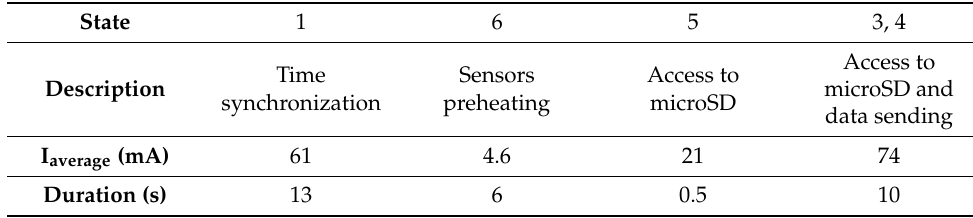
Figure 8. Node B—mode (i): NTP sync, sensor reading and data sending (once every 24 h). Table 6. Description of functional states of node B—mode (i).